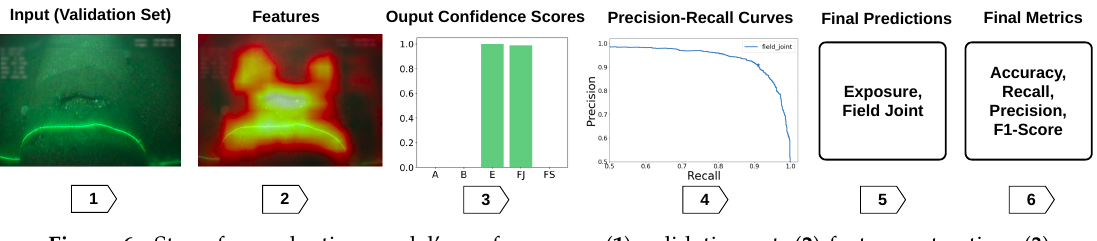
Figure 6. Steps for evaluating model’s performance: ( 1 ) validation set, ( 2 ) feature extraction, ( 3 ) classifier, ( 4 ) precision–recall curves for optimal thresholds selection, ( 5 ) applying optimal thresholds, ( 6 ) comparison with ground truth.